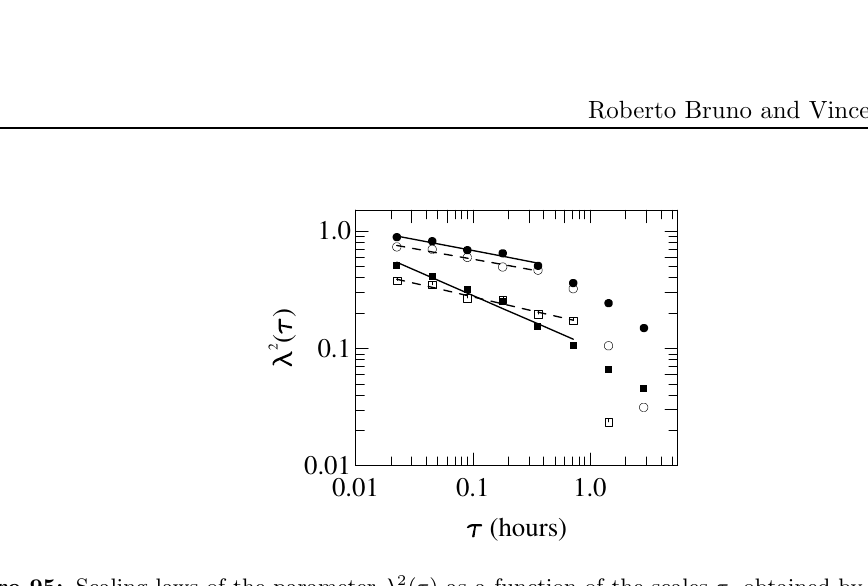
log-L´evy theories, 10 modified by self-organized criticality proposed by Schertzer et al. (1997), seems to avoid all problems present in other cascade